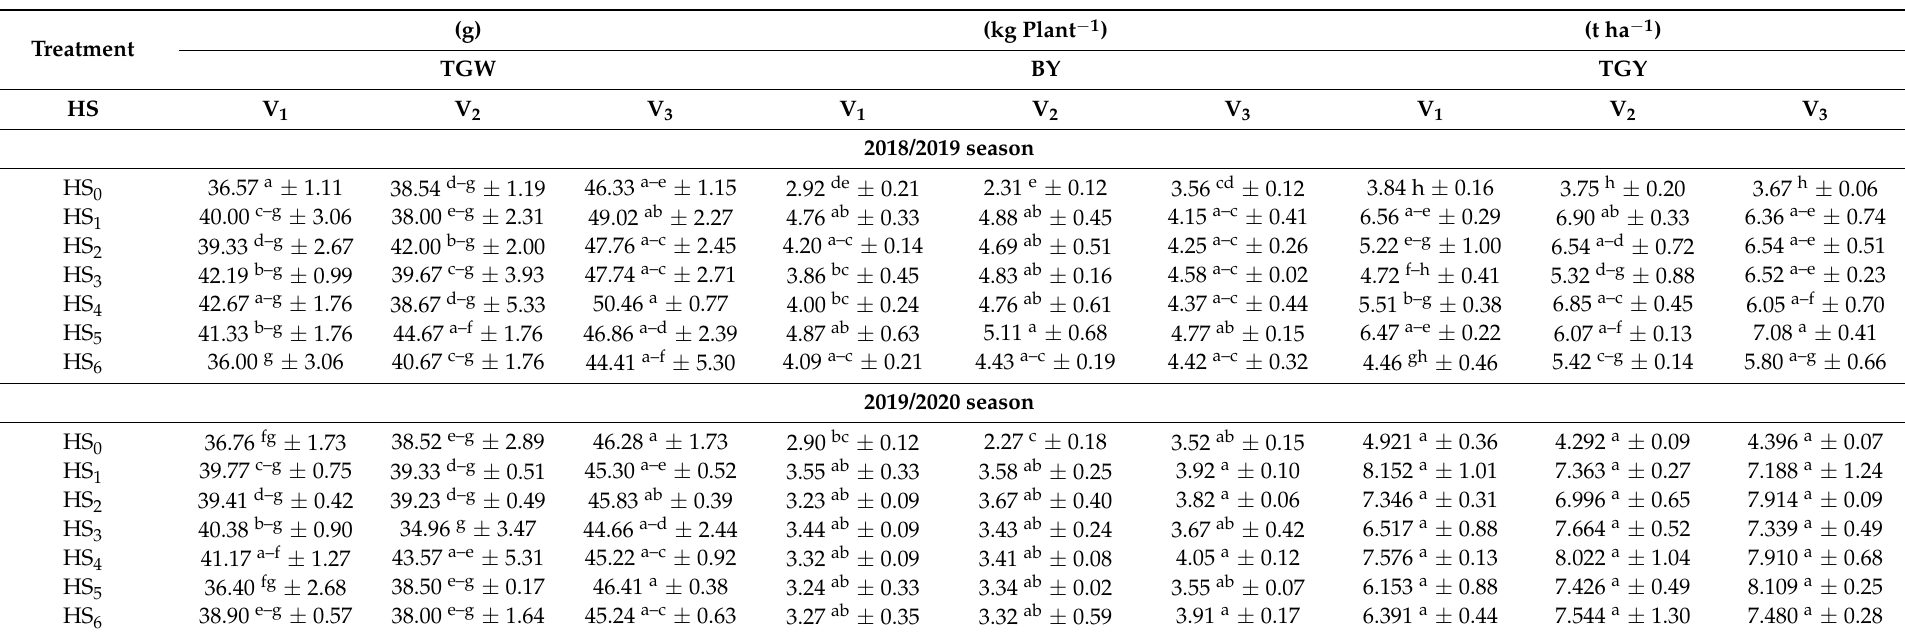
Table 7. Influence of humic substances doses on 1000-grain weight, biological yield and total grain yield of some wheat varieties grown in clay soil in 2018/2019